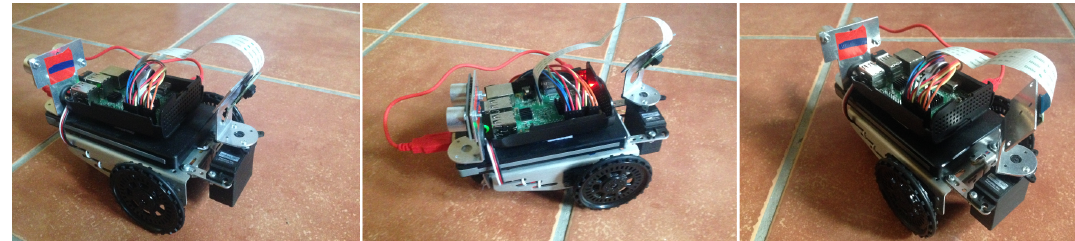
Figure 13. Robot and camera are continuously moving with respect to several